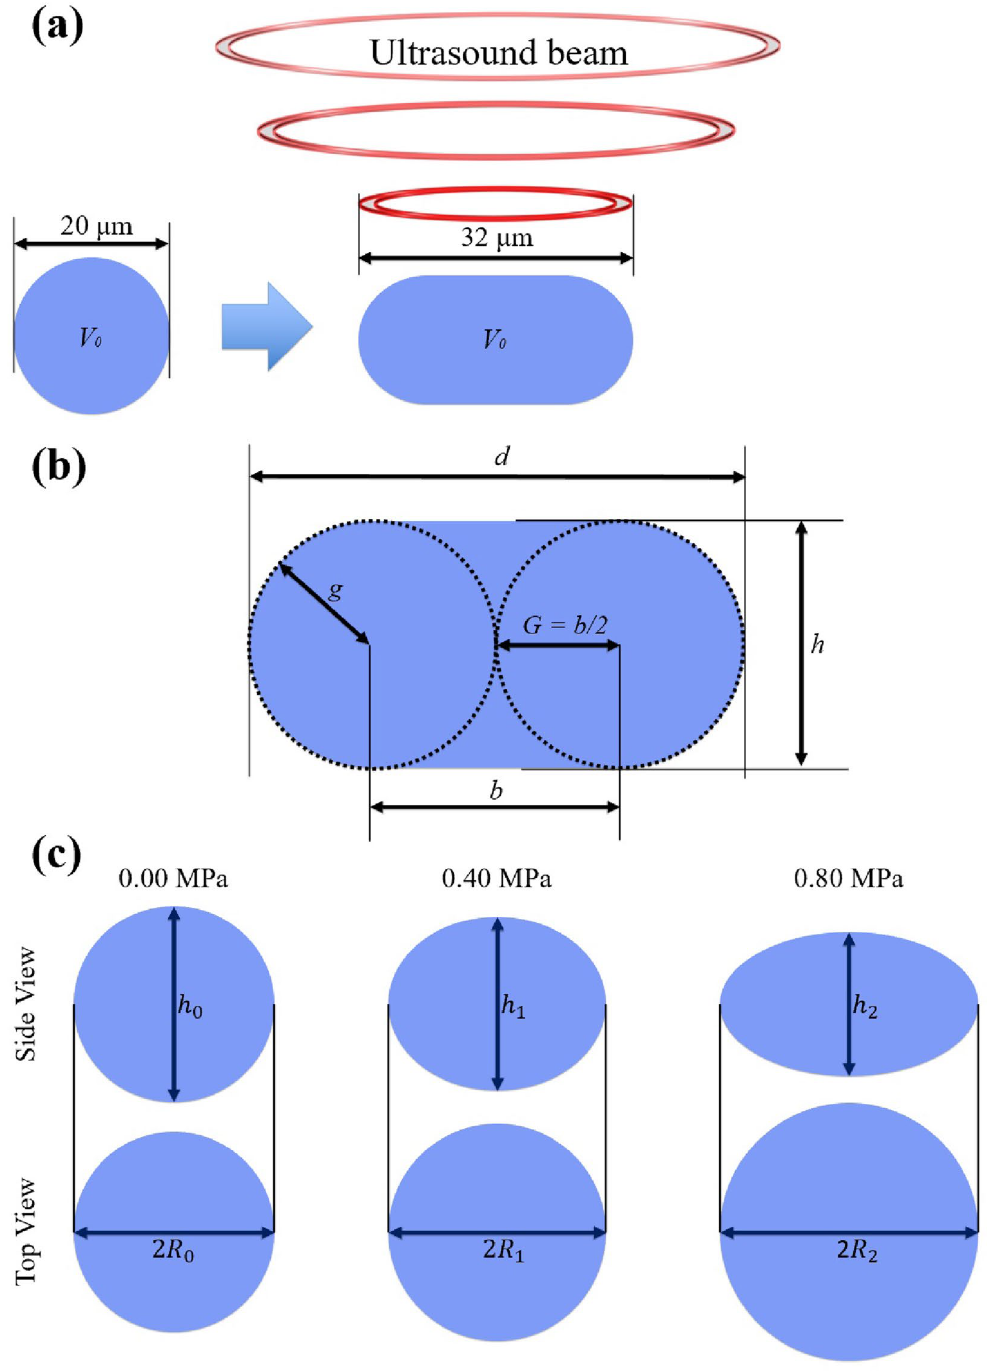
Figure 1. Schematic of the mathematical cell deformation model. ( a ) The initial cell shape is spherical and gradually flattens under SBATs. ( b ) Two circles drawn within the deformed cell represent the height of the 2 g , the radius of the two circles g , the diameter of the deformed cell d 2 G b cell after deformation h = = + b / 2 ), and the distance of the centers of two circles b . ( c ) Young’s modulus E is inversely proportional to ( G = 1 changes in h , which is measured in the vertical direction of the pressure P ( E (cid:31) h ). However, the existing ∝ π R 2 , where 2 R d ) are directly proportional to pressure, method assumes that changes in cell areas ( A ≃ = 1 41 and the average ratios of the changes are inversely proportional to the Young’s modulus ( E (cid:31) A ). Lim et al. ∝ 1 created reference points using E (cid:31) h , while they estimated the Young’s modulus using the reference points and ∝